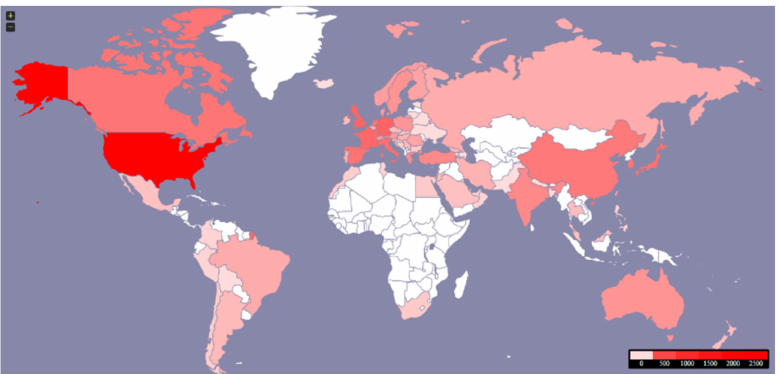
Figure 4. Worldwide distribution of 7658 articles published on NETs between 1981–2020.